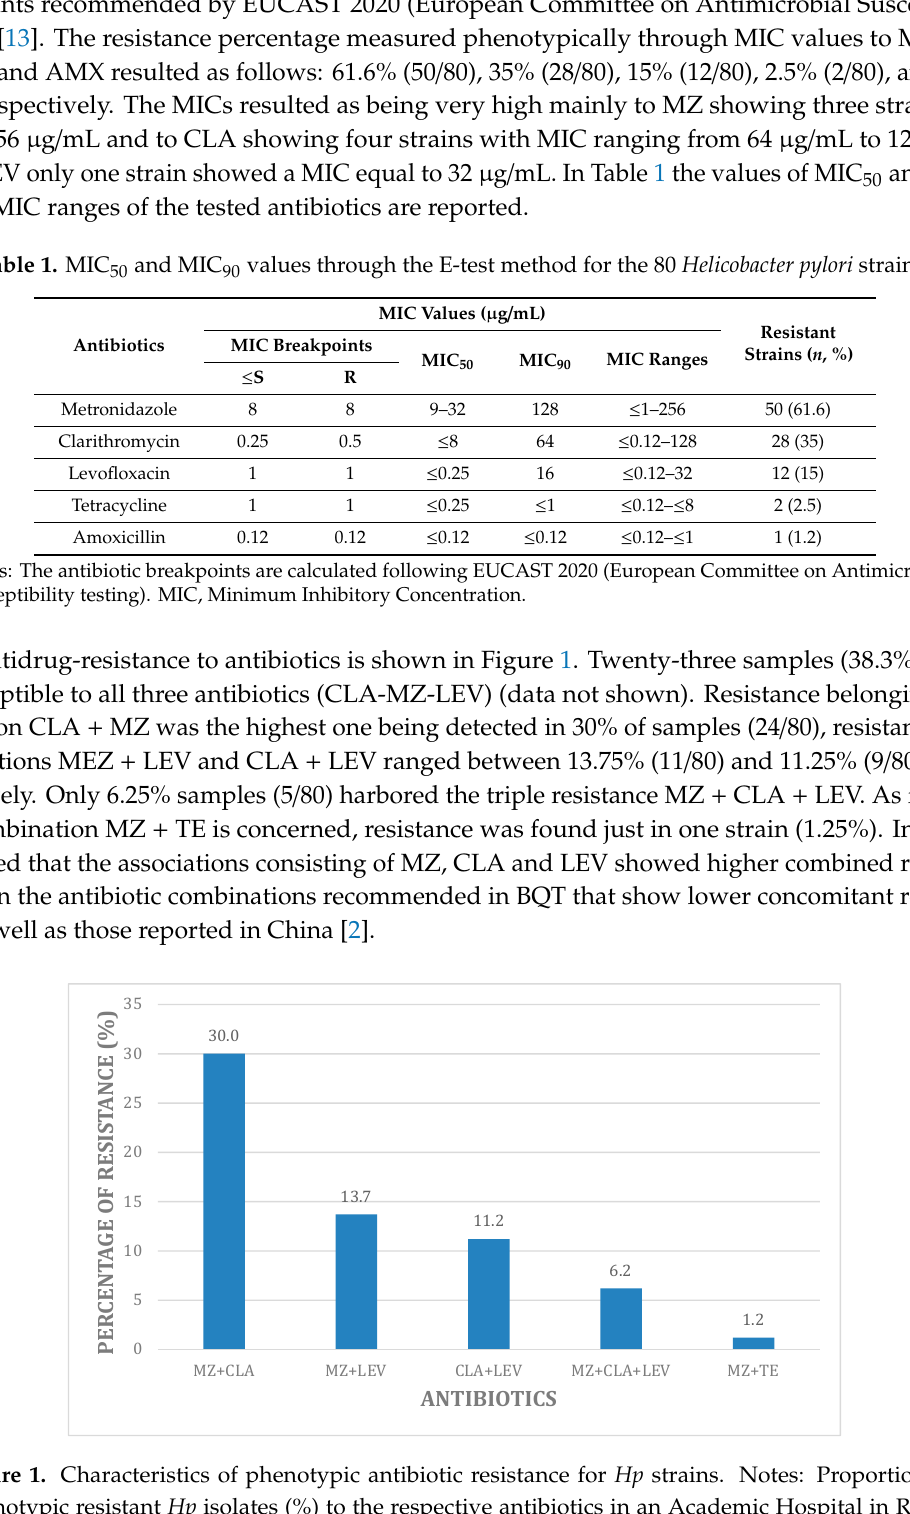
Table 1. MIC 50 and MIC 90 values through the E-test method for the 80 Helicobacter pylori strains.